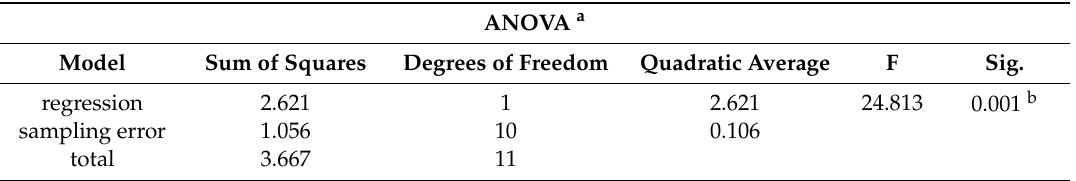
Table 5. Linear regression coefficients: In-situ density and topographic settlement.